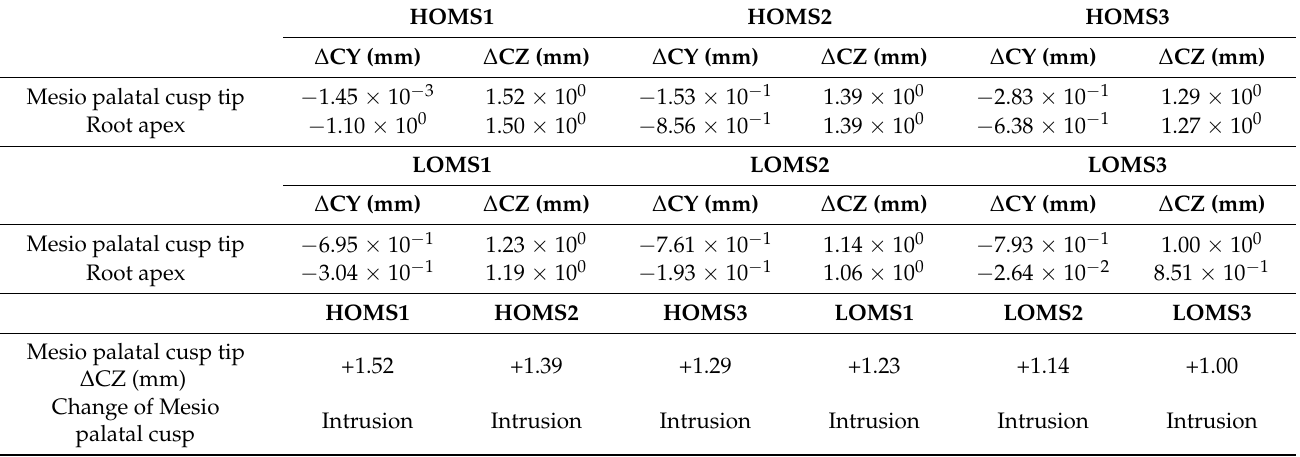
Table 7. Angle and difference in angle value of occlusal plane after initial and space closing. Angle of Initial Occlusal Plane (Deg.)